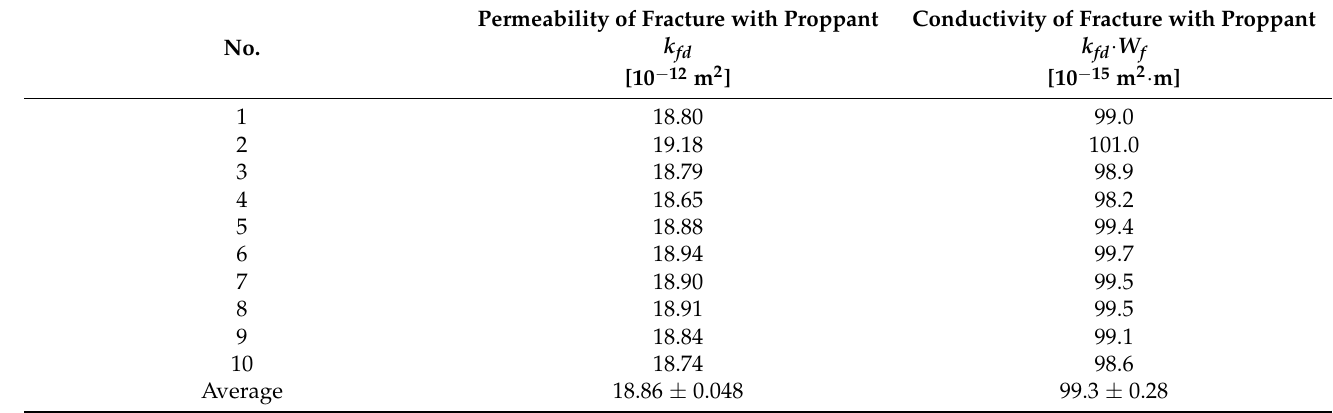
Table 7. The measurement results for the determination of the original conductivity and permeability of the fracture filled with quartz sand 20/40 damaged by the fluid FF1A at 60 ◦ C; compressing stress 27.6 MPa.